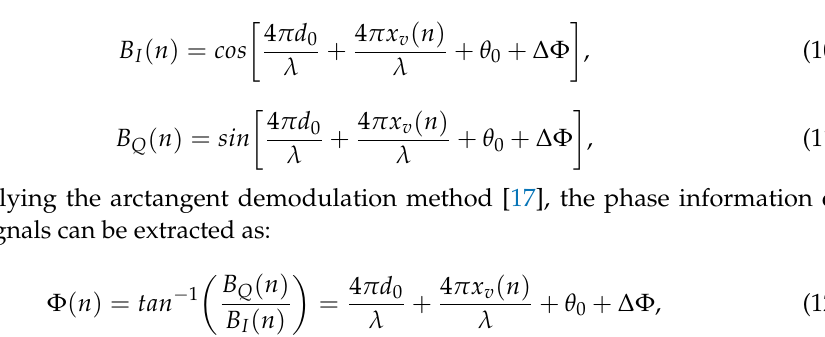
Figure 9. ( a ) Time domain vital sign signal of Target B; ( b ) the measured respiration and heartbeat rates of Target B using MTM LWA-based homodyne radar sensor module band [49].